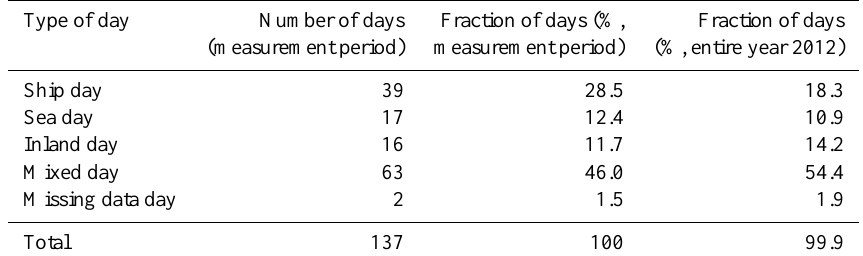
Table 1. Number and fraction of different types of days during our measurement period and during the entire year 2012.